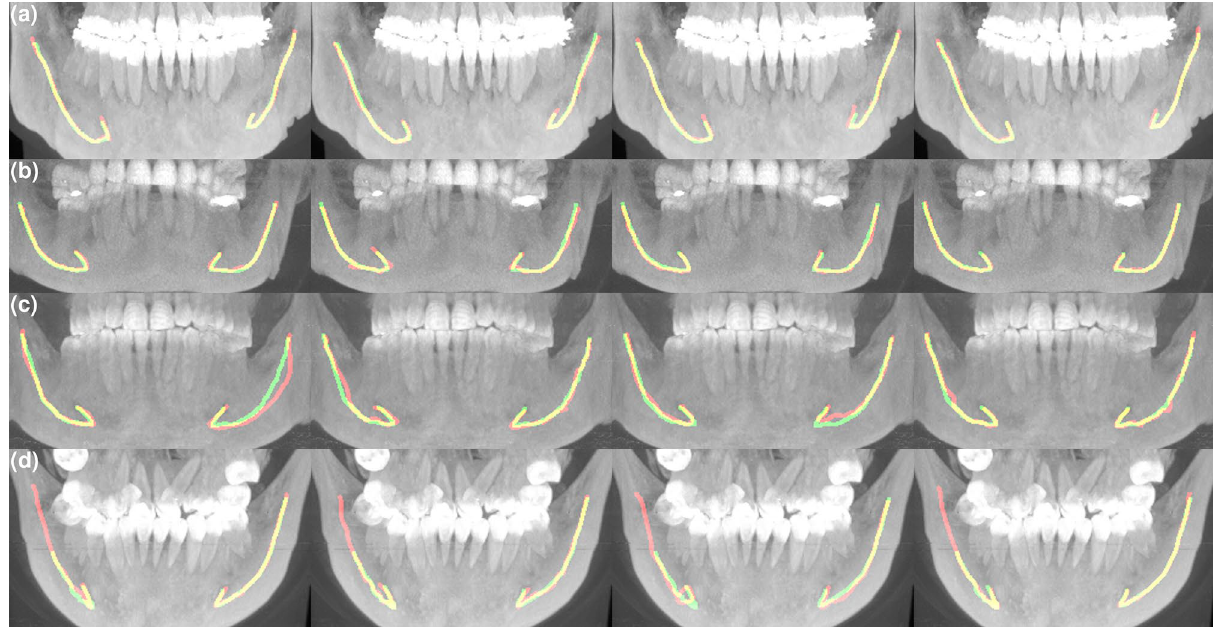
Figure 6. Maximum intensity projection of CBCT with overlaid expert and DLS segmentations. Every image on each column is annotated by the same expert, shown in red, DLS annotation shown in green, and overlap shown in yellow. ( a ) GiANO HR with 0.3 mm spacing, ( b ) a DentiScan with 0.4 mm spacing, and ( c , d ) DentiScan with 0.25 mm spacing, ( a , b ) Low interobserver variability (IV) and low DLS to expert variability (DV) on a scan with no heterogeneities and the both canals were labelled as Clear. ( c ) High IV with a scan labelled with difficult bone structure (DBS) and the left canal was labelled Unclear. ( d ) High DV where the DLS outcome was incomplete with a scan labelled with DBS, movement artefact, and the right canal labelled